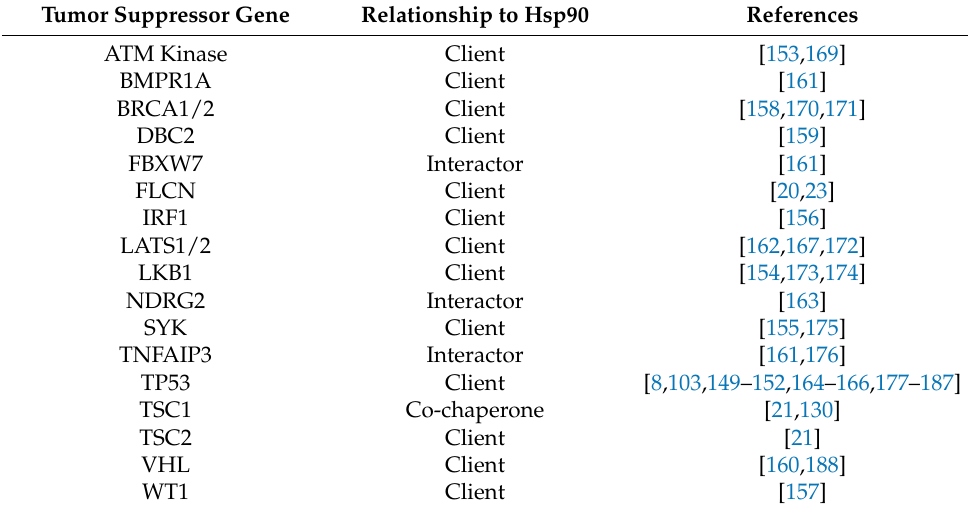
Table 1. Relationships of known tumor suppressor-Hsp90 interactions. Tumor Suppressor Gene Relationship to